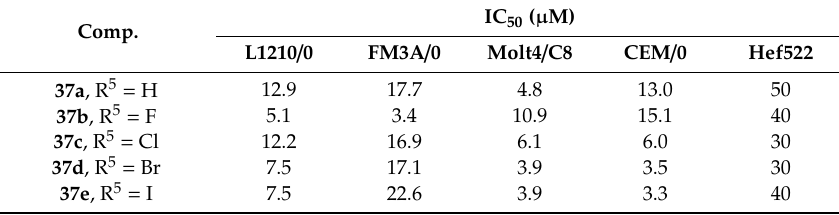
Figure 17. Pyrimidine and purine derivatives of L -ascorbic acid. Table 13. The cytostatic effects of the pyrimidine and purine L -ASA derivatives. Comp.